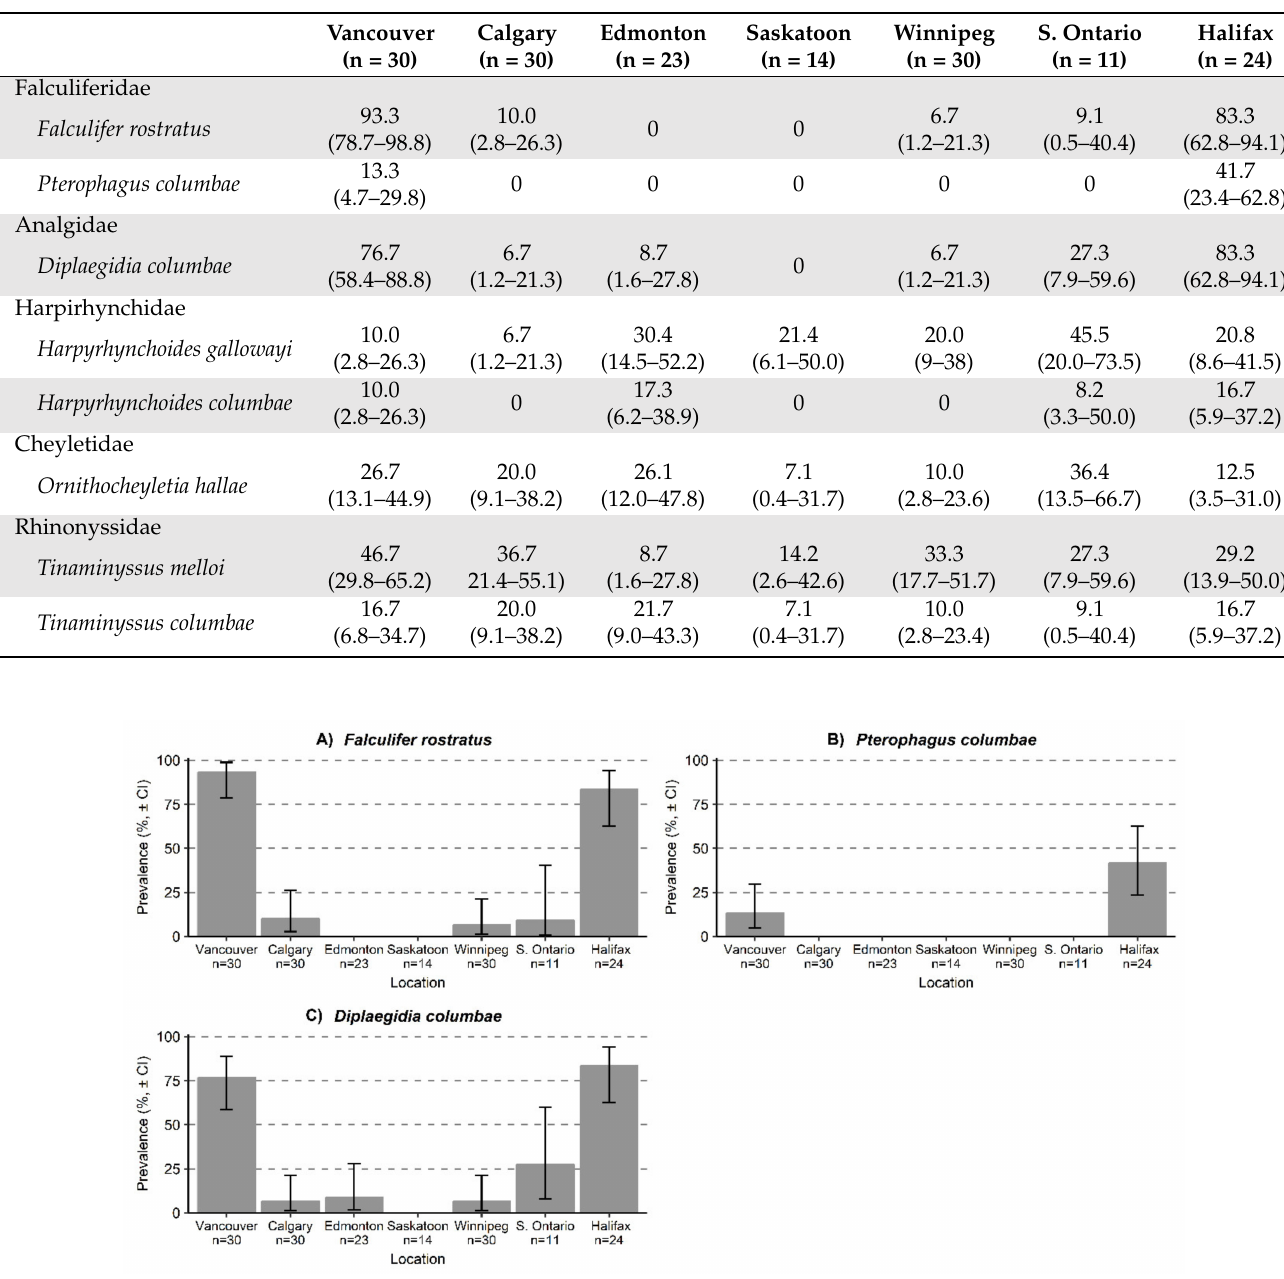
Table 1. Prevalence of mites found on Columba livia collected from seven locations across Canada. 95% confidence intervals in parentheses.